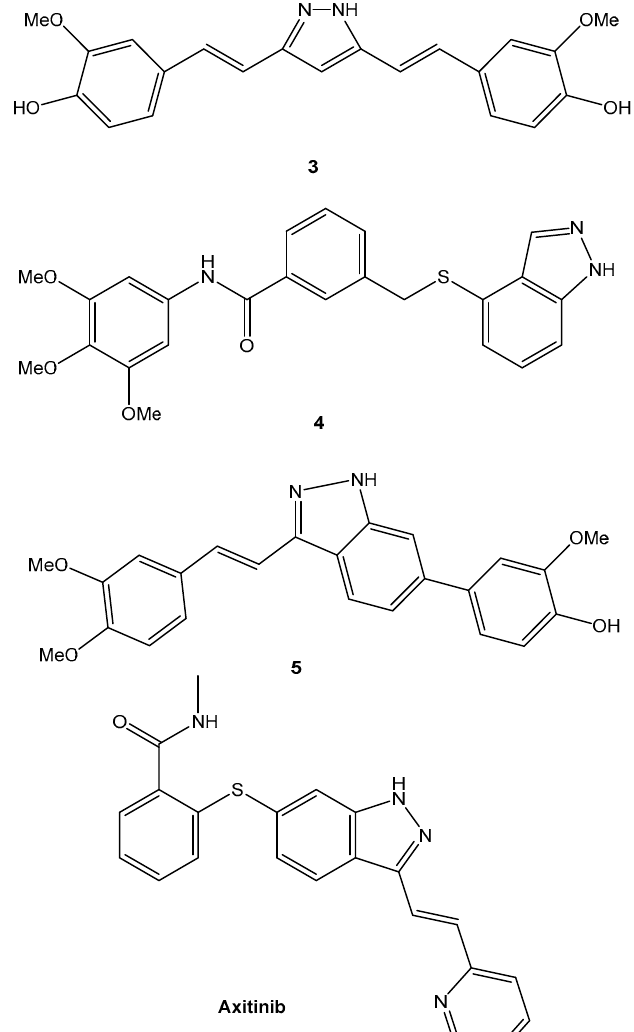
Figure 3 : Successful applications of computational methods in anticancer drug discovery. Figure 3. Successful applications of computational methods in anticancer drug Table 4. The list of FDA-approved anticancer drugs from the National Cancer Institute database.